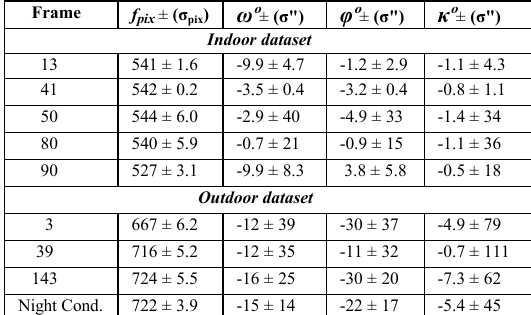
Night Table 1. LR-RANSAC derived camera parameters across several frames from indoor and outdoor image sequences place in a small concentrated section of the image space. It is assumed that the lack of matching features in these ‘control free’ image areas increases the level of uncertainty in estimated parameters. Based on GT comparison across 144 frames, mean absolute errors for parameters were: 13.2 pixels (0.07mm) for focal length, 0.28º for omega, 0.19º for phi and 0.30º for kappa. Based on general angular errors, accuracies are in the order of